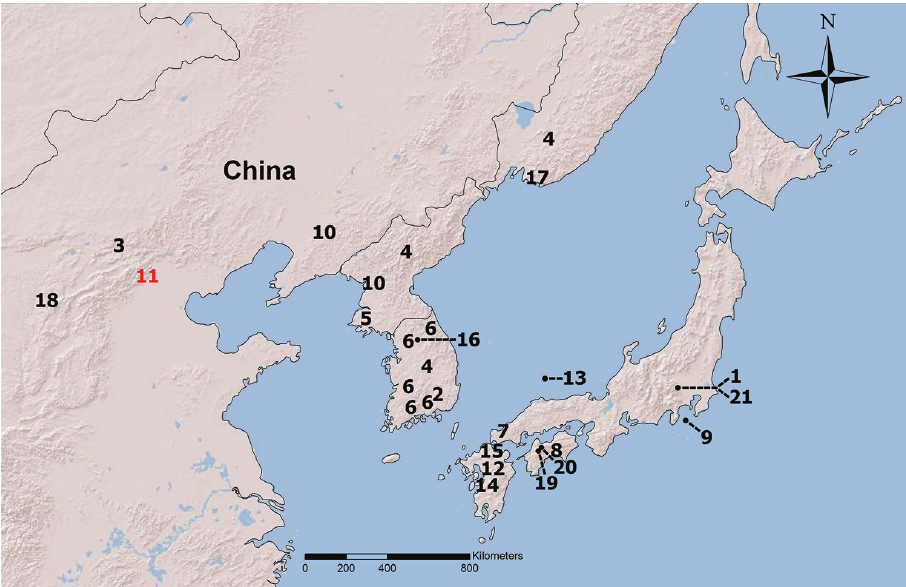
Figure 1. Summarized distribution map of species of Skleroprotopus . Numbers: 1 Skleroprotopus chichib- uensis Shinohara, 1960 2 S. chollus Mikhaljova & Korsós 2003 3 S. confucius Attems, 1901 4 S. coreanus (Pocock, 1895) 5 S. costatus Mikhaljova & Korsós, 2003 6 S. hakui Takakuwa, 1940 7 S. ikedai